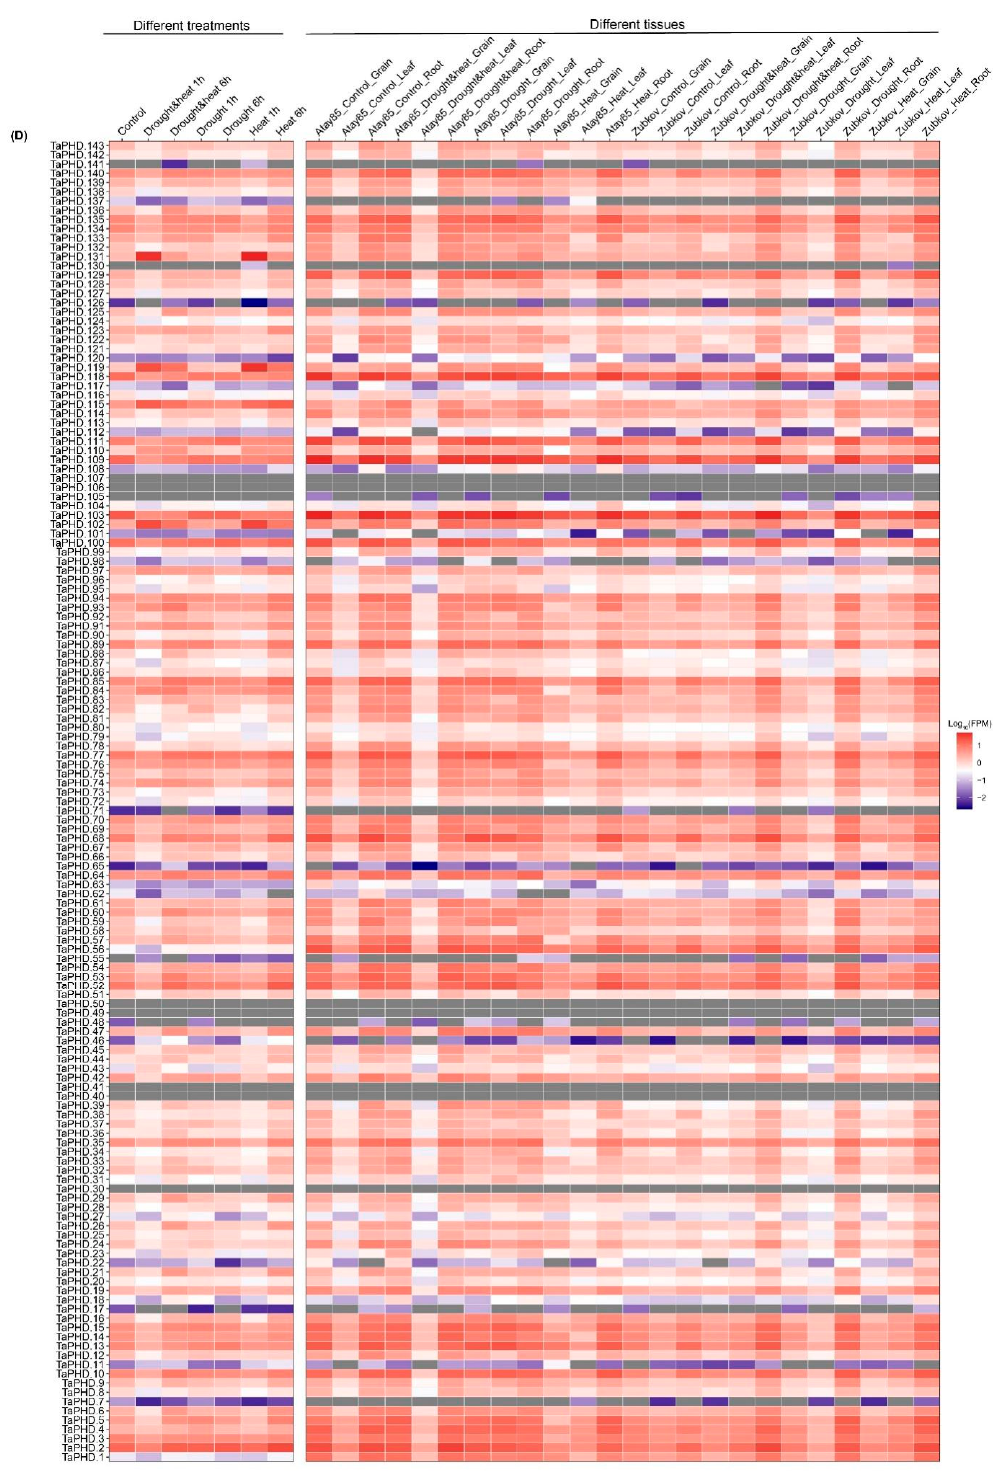
Figure 7. TaZFP gene expression levels heatmap at different treatment times and tissues under drought stress. TPM values were scaled by the logarithm of the base 10 to form the